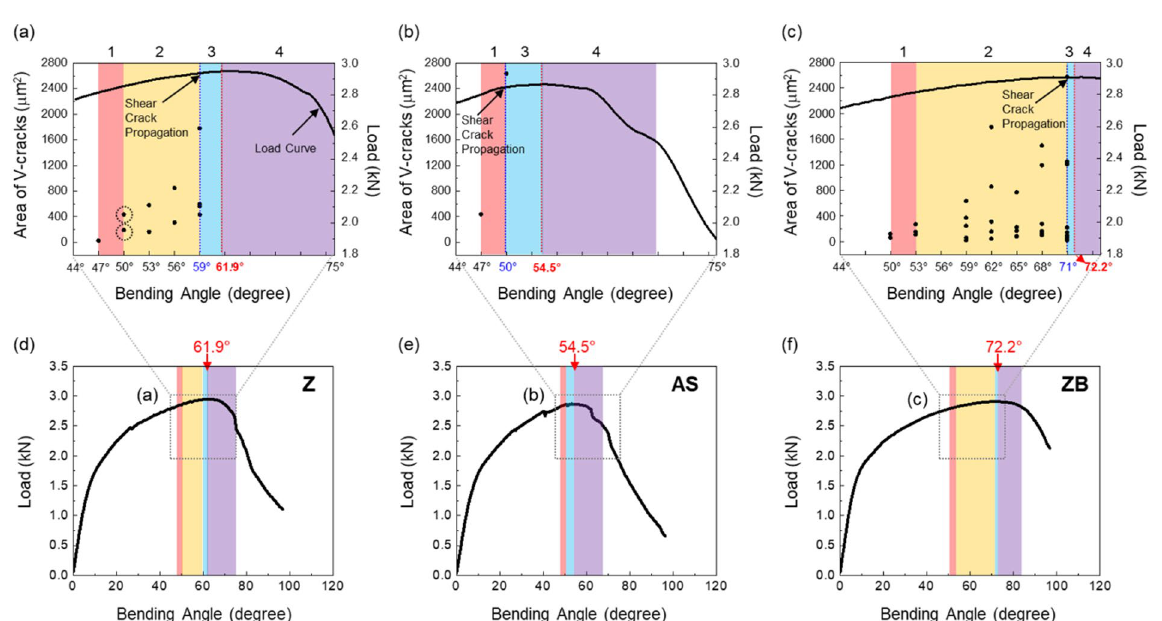
Figure 9. ( a – c ) Area and number of V-cracks and ( d – f ) bending load as a function of bending angle for the Z, AS, and ZB steels. The bending angle range (44°–75°) of the dashed-line boxes of ( d – f ) is shown in ( a – c ). The four bending stages are indicated respectively by orange, yellow, light-blue, light-purple colors in these